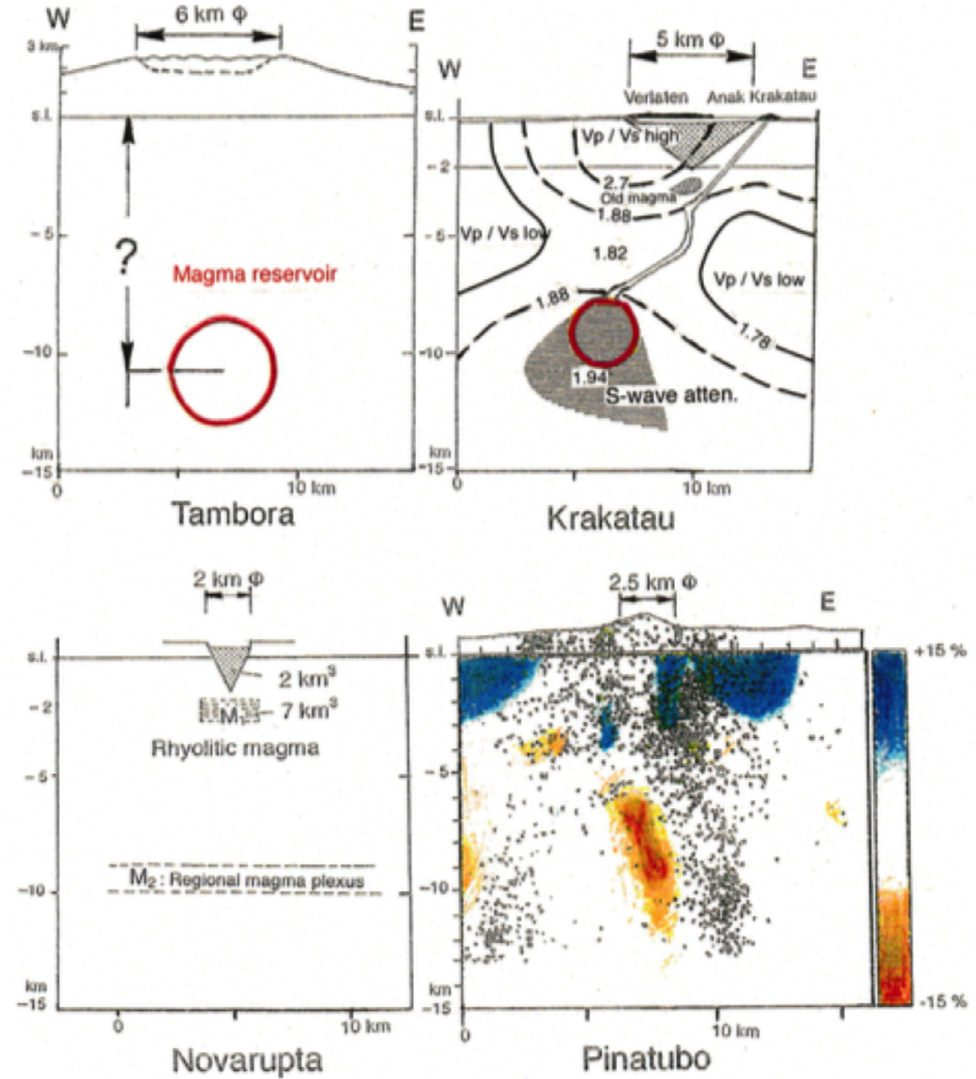
Figure 2. Proposed models of subsurface structure of the four calderas. Tambora : probable volume of a magma reservoir is shown as 41 km 3 (cf. Kandlbauer and Sparks [2014]) and its depth is not determined. Krakatau (mainly by Yokoyama [2015a]): synthesized from gravity anom- alies and seismological data. Dotted part consists of caldera deposits. Vp/Vs ratios are contoured and high S-wave attenuation is marked by stripes. Volume of the magma reservoir is assumed as 19 km 3 (cf. Yokoyama [2015a]). Novarupta (mainly by Hidreth [1983]): M is regional plexus of magmas in forms of sills, dikes and small chambers. Pinatubo (mainly by Mori et cross-section beneath the caldera, M 2 al. [1996]): magma bodies of 40~90 km 3 are detected at a depth of 6~11 km. The black dots represent post-eruption earthquake foci from June 29 to August 16,